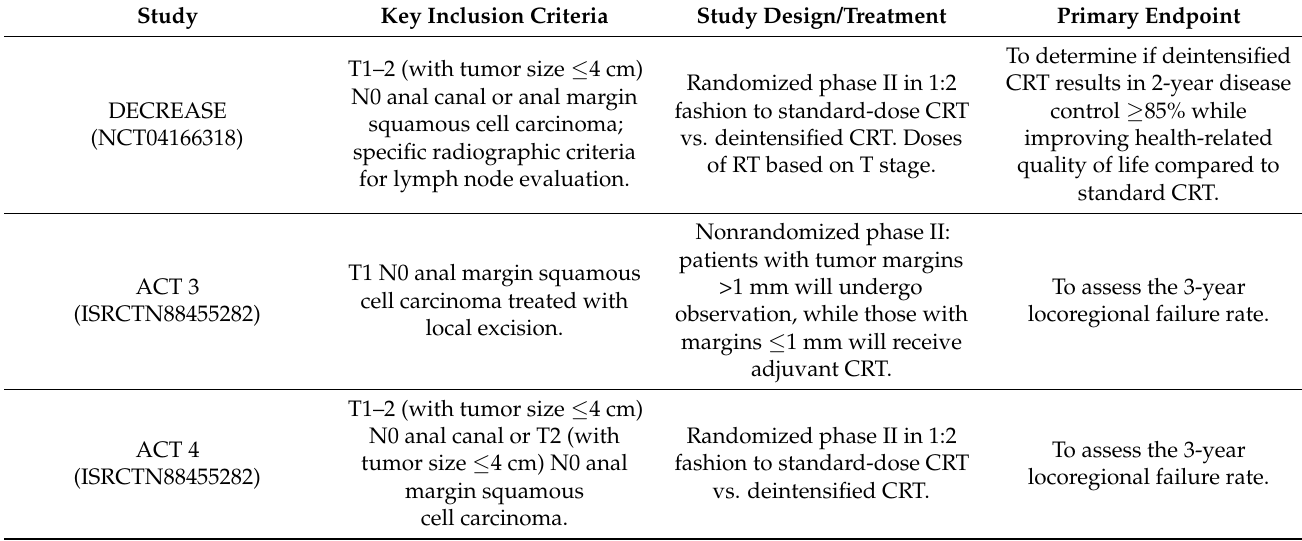
Table 2. Summary of current de-escalation studies for early-stage squamous cell carcinoma of the